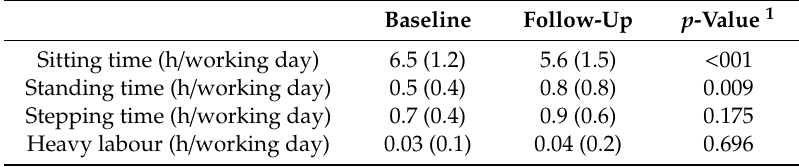
Table 2. Occupational sitting and Physical Activity Questionnaire (mean ± SD; n = 39).